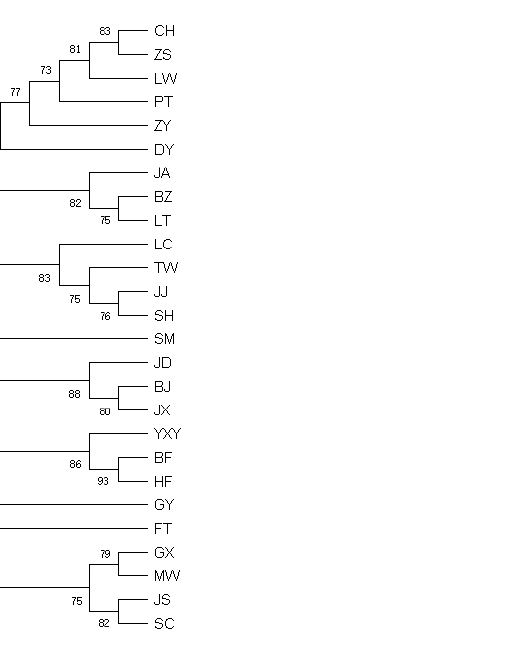
Figure 5. The median-joining networks of mtDNA D-loop haplotypes. The colors represent di ff erent duck populations.